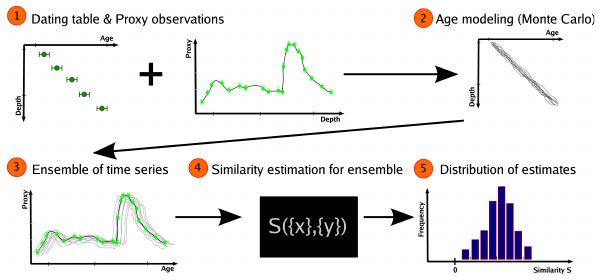
Fig. 3. How much age uncertainty is allowed to still enable re- liable similarity estimation? Artificial stalagmites with increasing standard deviations of the ages are